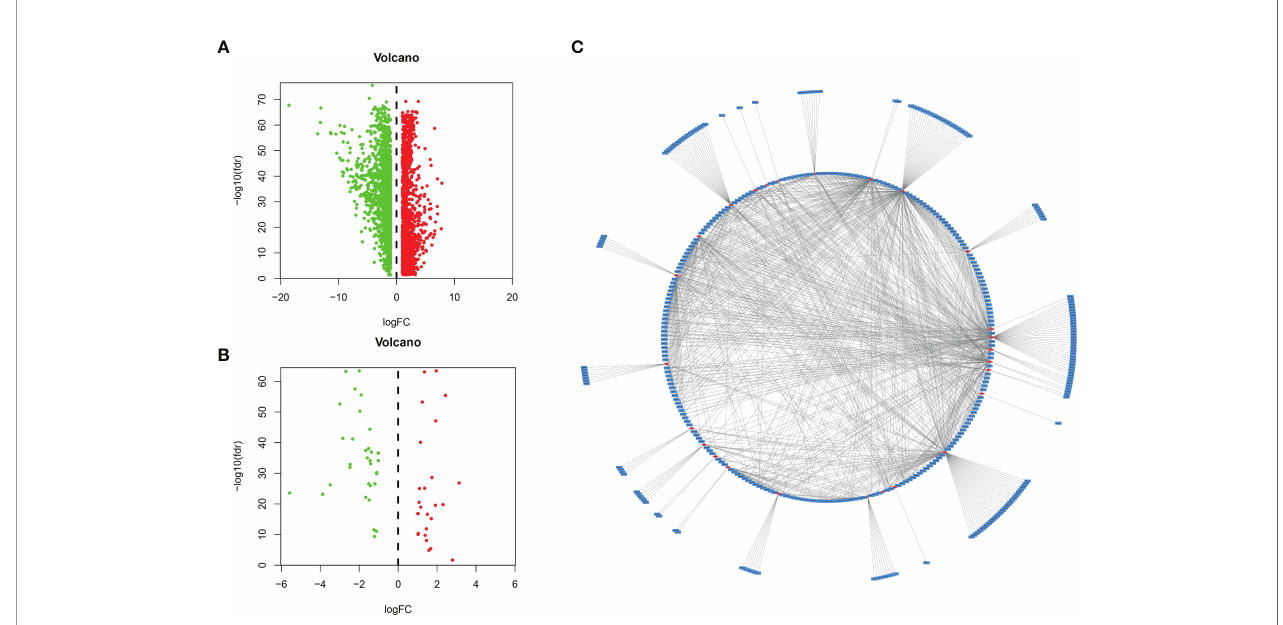
FIGURE 1 | Identi fi cation of lncRNAs related to immune genes by coexpression analysis. (A) Differentially expressed genes were expressed in hepatocellular carcinoma and normal tissues, and (B) 59 immune-related genes were obtained by further analysis. Green and red points indicate downregulated and upregulated lncRNAs in volcano plot, respectively. (C) Coexpression analysis of lncRNAs associated with immune-related mRNAs, and obtained 401 immune-related lncRNAs (P < 0.01 and |cor| > 0.3, red for mRNAs, blue for